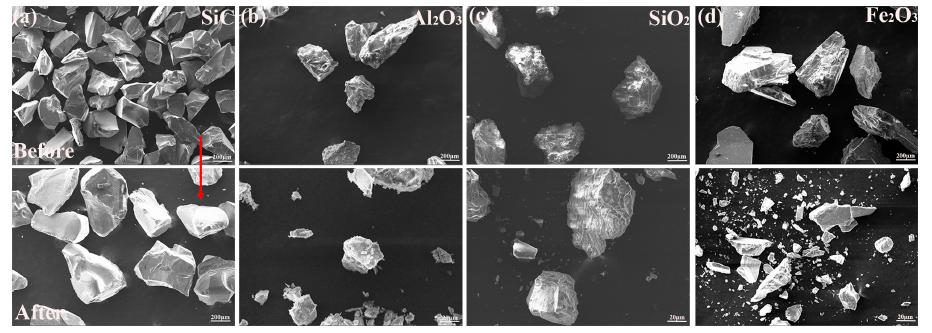
Figure 8. SEM micrographs of the abrasives before and after the wear: ( a ) SiC, ( b ) Al 2 O 3 , ( c ) SiO 2 , ( d ) Fe 2 O 3 .